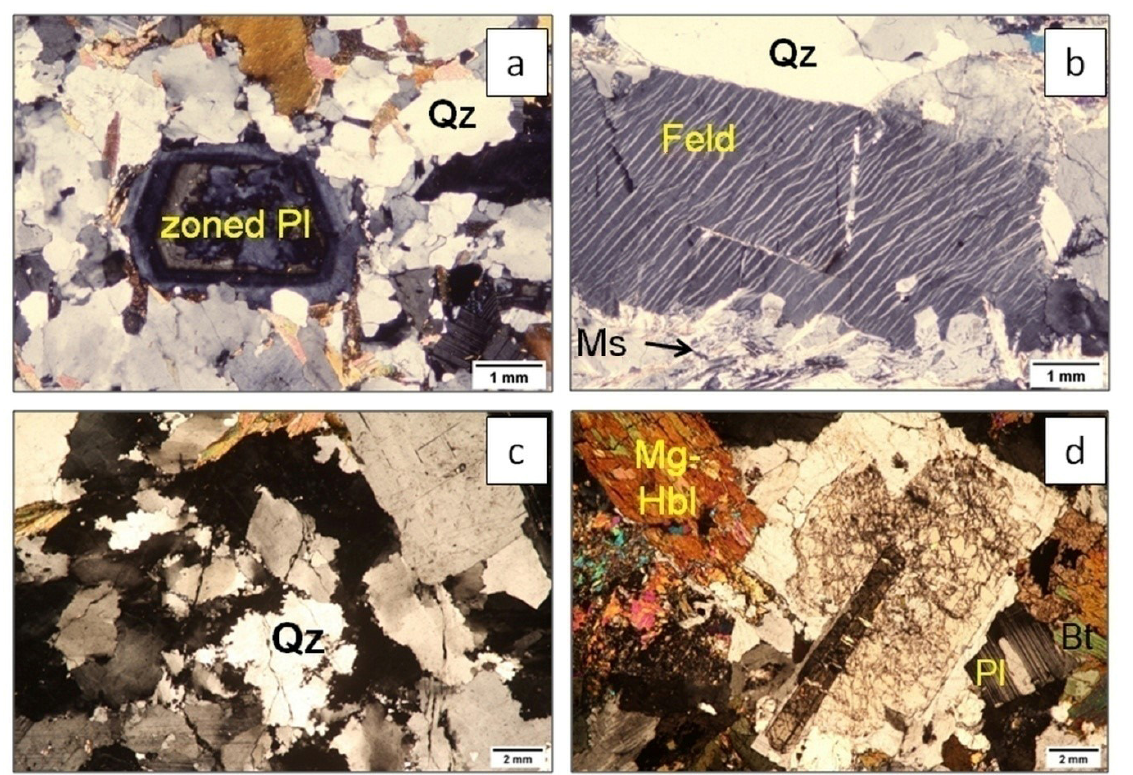
Figure 6. ( a ) Cross polarized light (XPL) image of a zoned plagioclase (Pl) from CATr (sample AP2). ( b ) XPL feldspar porphyroclast containing flame perthites in a quartz + muscovite (Qz + Ms) bearing groundmass (sample A2432). ( c ) XPL image of a recrystallized quartz in tectonically deformed granodiorite at the northern border of Corno Alto (sample A2432). ( d ) XPL image of a zoned plagioclase (Pl) porphyroblast in contact with hornblende (Mg-Hbl) and biotite (Bt) from MCD (sample